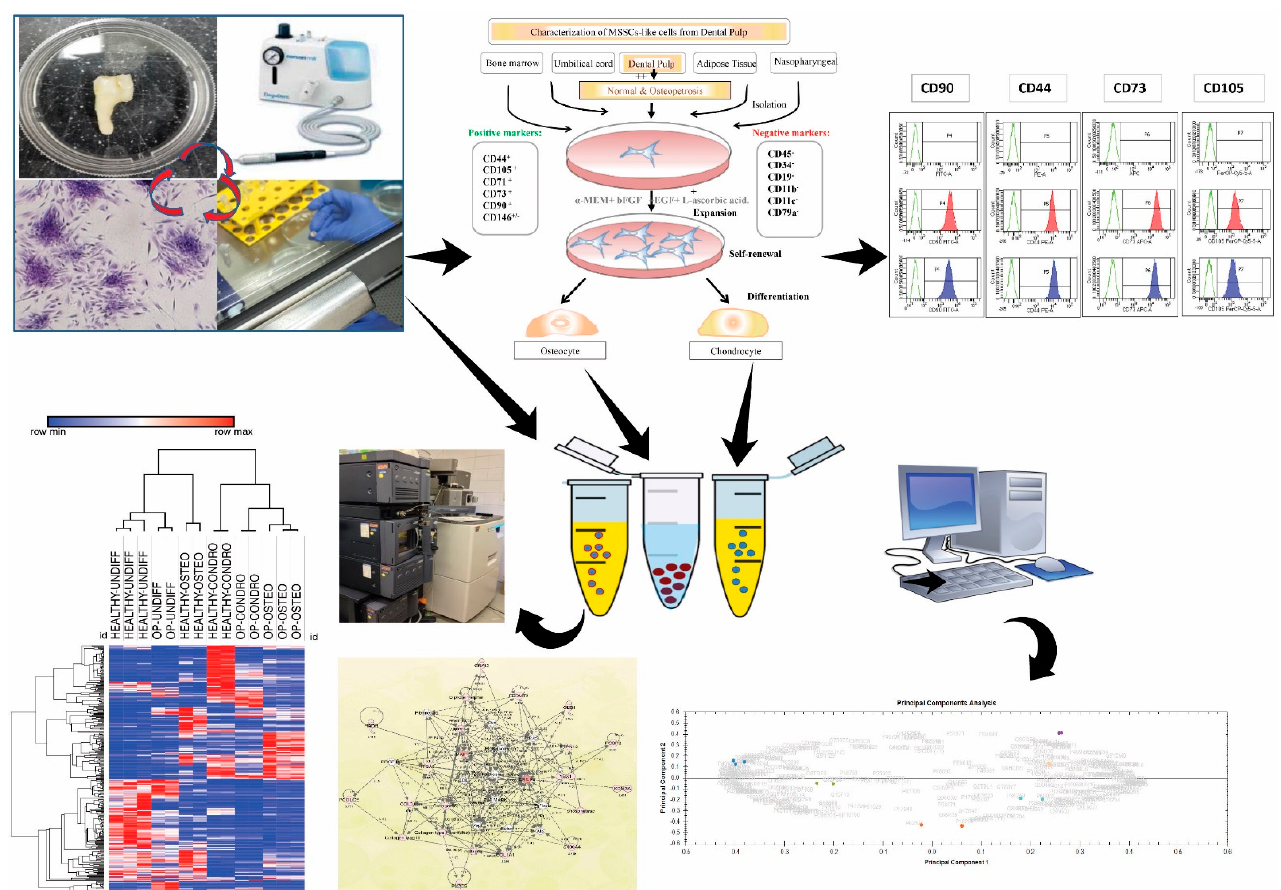
Figure 1. Workflow illustration: Mesenchymal cells were isolated from the dental pulp of recently extracted deciduous teeth from osteopetrosis (OP) patients and healthy control (HC) subjects. The dental pulp mesenchymal cells were differentiated into osteocytes and chondrocytes. Cells were further characterized using by proteomics using label-free quantitative liquid chromatography tandem mass spectrometry (LC–MS/MS). The details of the clinical characteristics of all the samples are listed in Table 1. Table 1. Clinical characteristics of study patients.